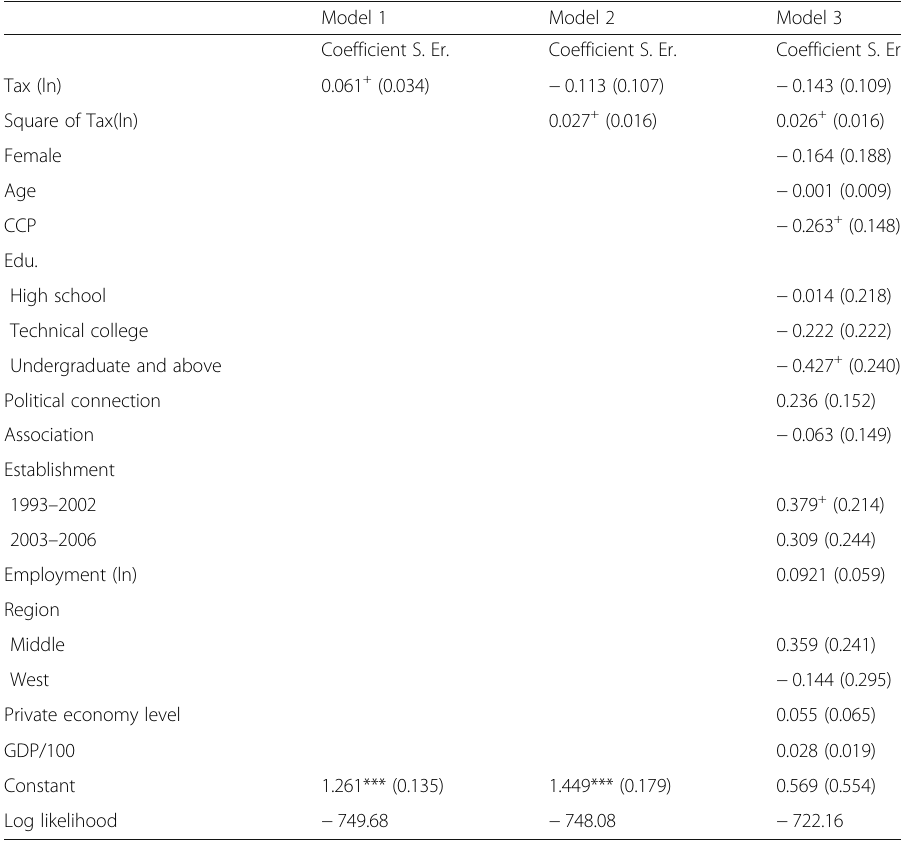
Table 3 Parameter estimates for taking action ( N =